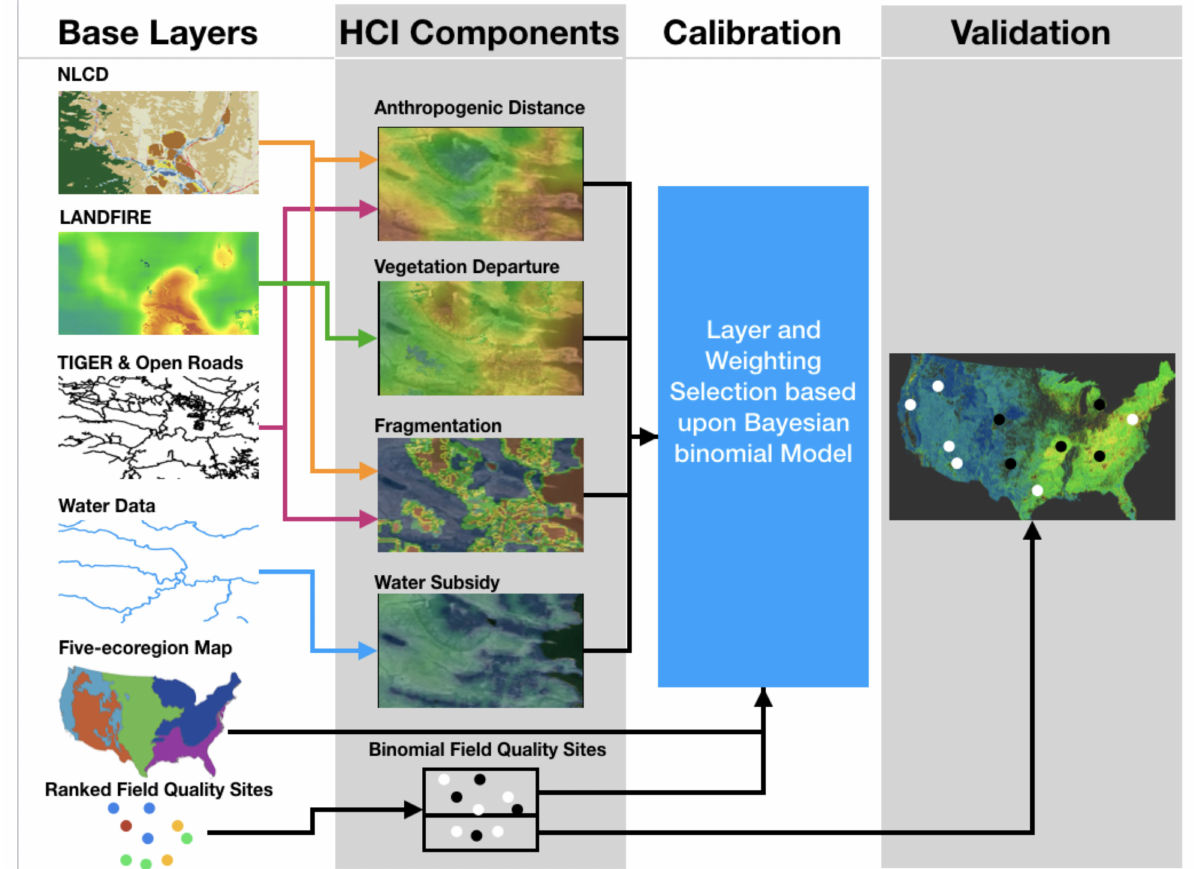
Figure 1. The HCI tool was created by overlaying several CONUS-scale source datasets that depict various natural and anthropogenic features of the landscape. Component datasets were created based upon elements of the source data see methods and Supplemental S1 (Supplementary Materials) for complete description, see S1 Table S1 Identifying and Assembling Component Data